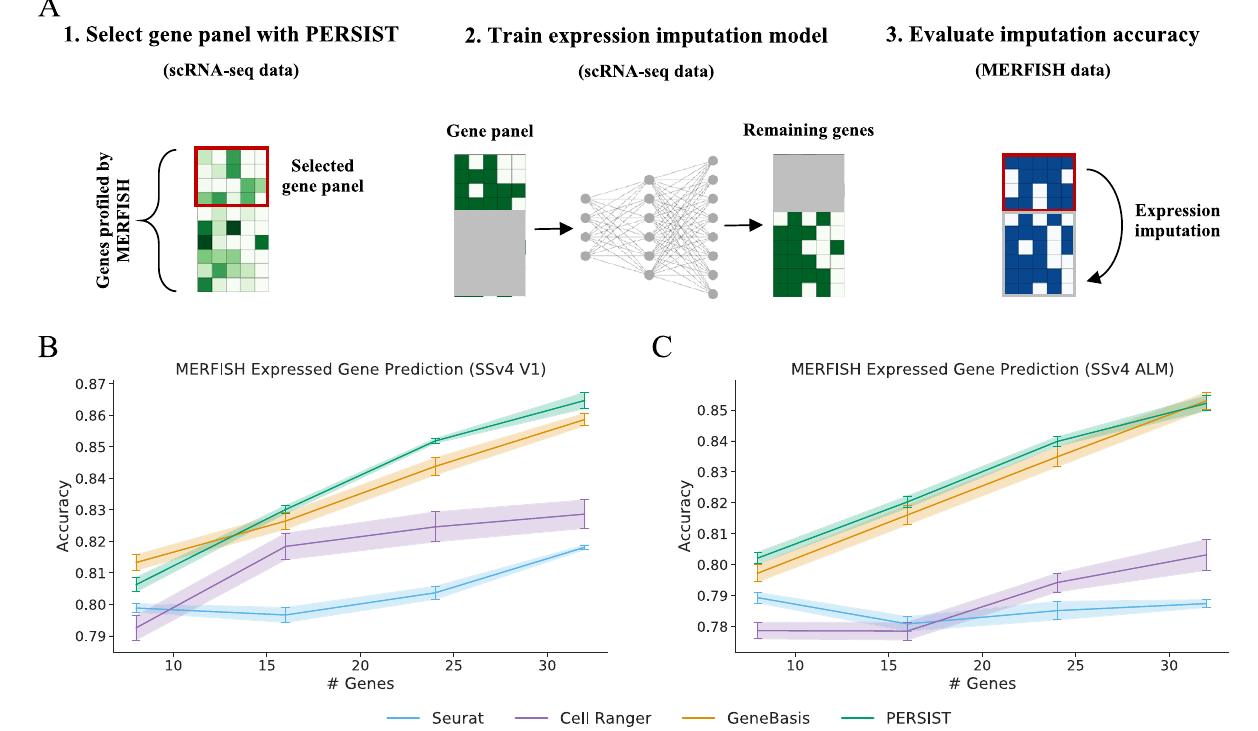
Fig.5|PredictingMERFISHgeneexpressionaftertrainingwithscRNA-seqdata. TotestwhethermodelstrainedonscRNA-seqdatacantransfertoFISHdespitethe domain shift betweentechnologies, we design anexperiment combining SSv4 and MERFISH measurements. We fi nd that binarizing gene expression levels enables accurate predictions in MERFISH cells, and that PERSIST outperforms prior gene selection approaches. A Inthis multi-stepexperiment, agene panelis fi rst selected using scRNA-seq restricted to the genes pro fi led in the MERFISH data. Next, an imputationmodelistrainedtopredictwhethertheremaininggenesareexpressed, again using scRNA-seq data. Finally, the imputation model ’ s accuracy is tested on